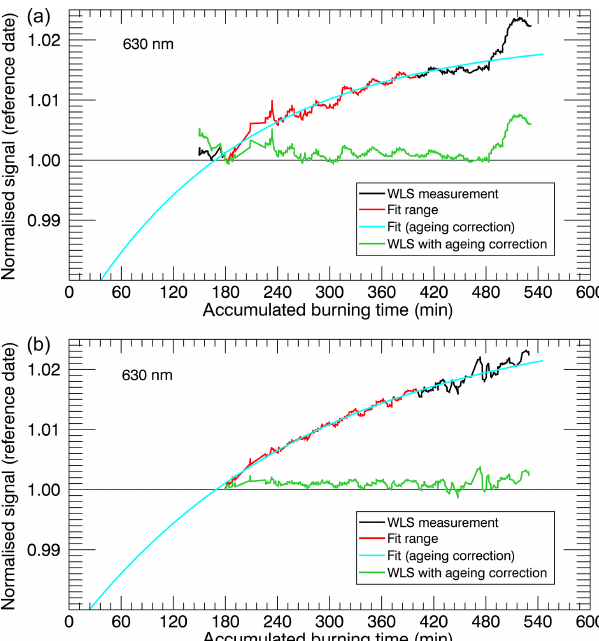
Figure 5. Relative WLS intensity at 630nm as a function of its ac- cumulated burning time in orbit. (a) WLS measurements in ESA V9.01 calibration; (b) after the final iteration of the modified degra- dation model. The black curve shows the WLS measurements. The (fit) range that is used to derive the parameterisation of the WLS change is indicated in red. The best fit to describe the ageing of the WLS is plotted in light blue. The corrected WLS measurements as used in the degradation model are shown in